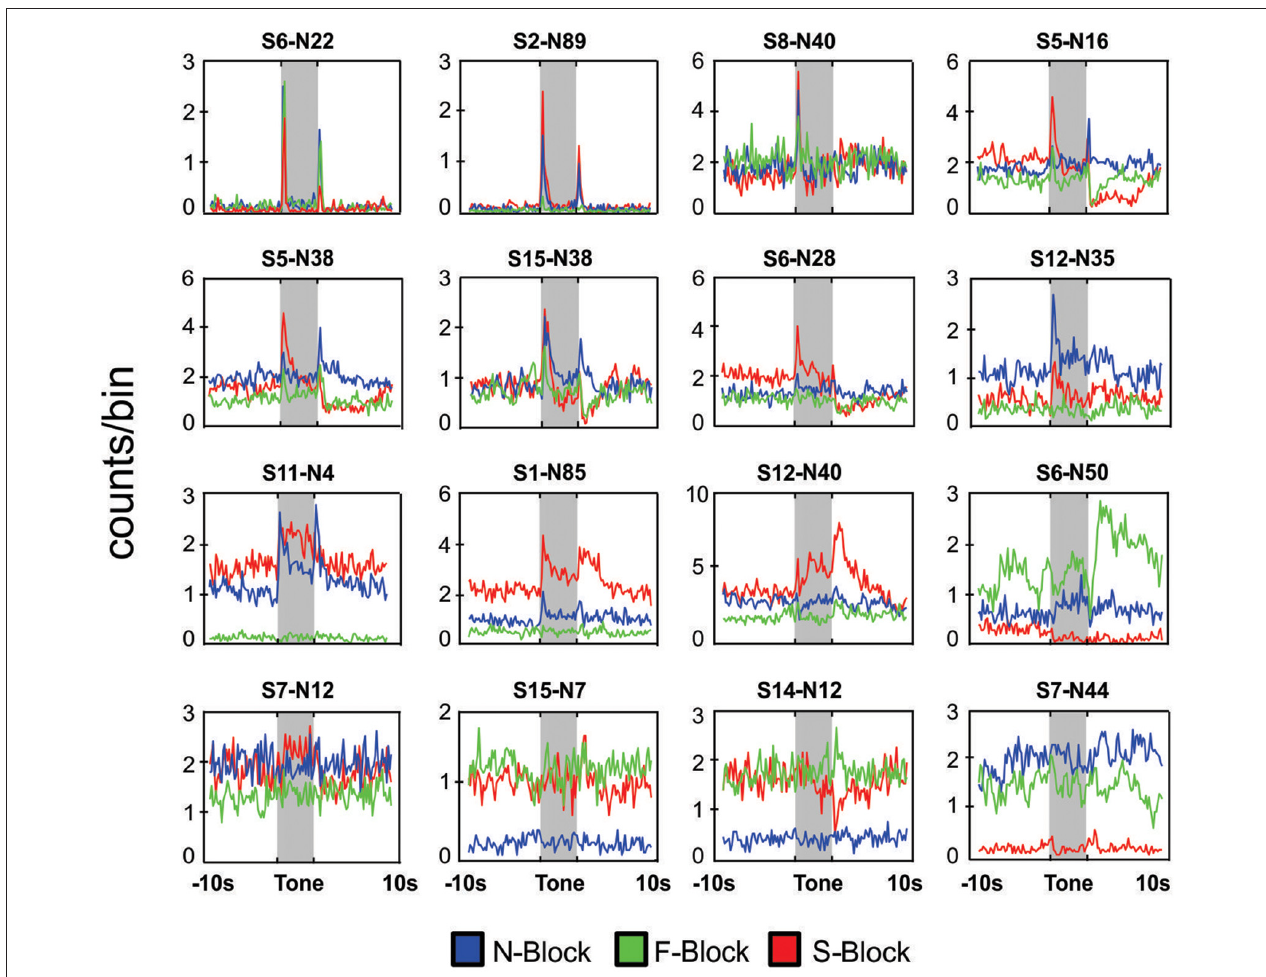
FIGURE 3 | Neuronal responses in block sessions. Peri-event histograms of neuronal responses during a 20 s period centered on tone onset for 16 different neurons that were each recorded during an N-block (blue), F-block (green) and S-block (red). In each case the tone lasted for 5 s (shaded area) and was immediately followed by the outcome. Placement of the panels was based on the type of response: neurons that responded mainly the tones or the outcomes are presented in the top rows whereas those exhibiting strong block offsets are presented in the bottom rows. The numbers above each panel denote the session and neuron